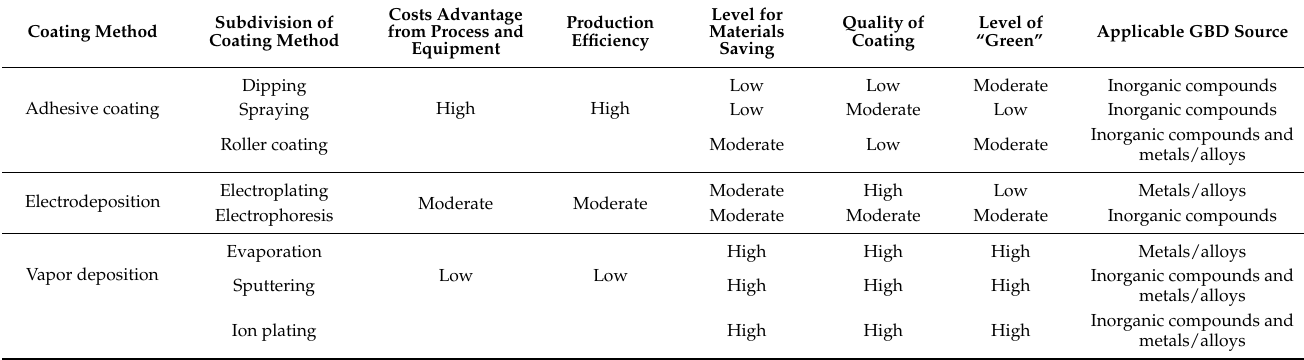
Table 2. Advantages, disadvantages, and application ranges of various coating methods for depositing GBD sources. Coating Method Subdivision of Coating